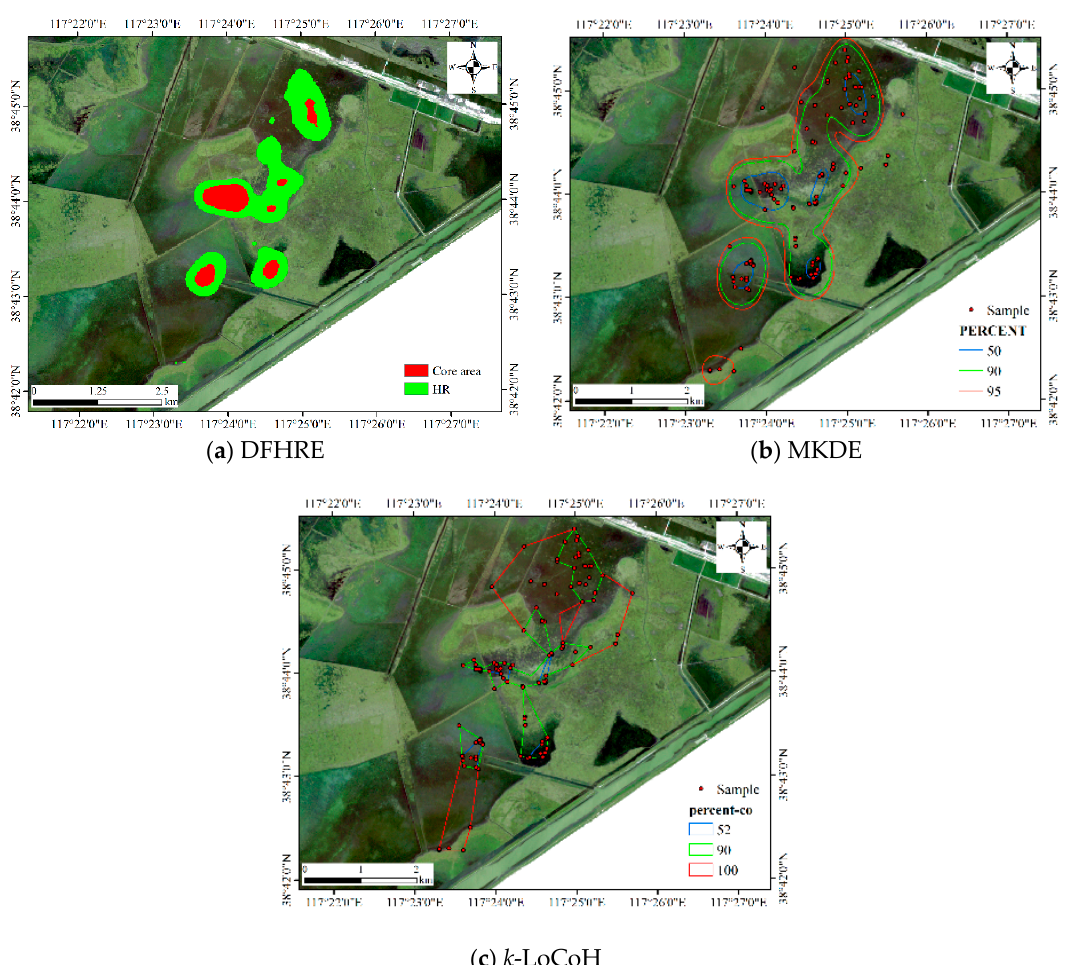
Figure 19. HRs of the DFHRE, multivariate kernel density estimation (MKDE) and k -LoCoH methods for Dataset 1.